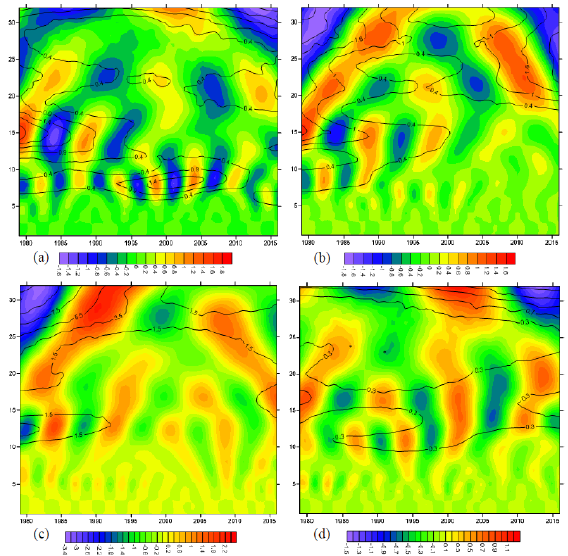
Figure 7. Wavelet analysis results for change cycle of sea ice extent in (a) Barents, (b) Greenland, (c) Baffin & Lawrence and (d)